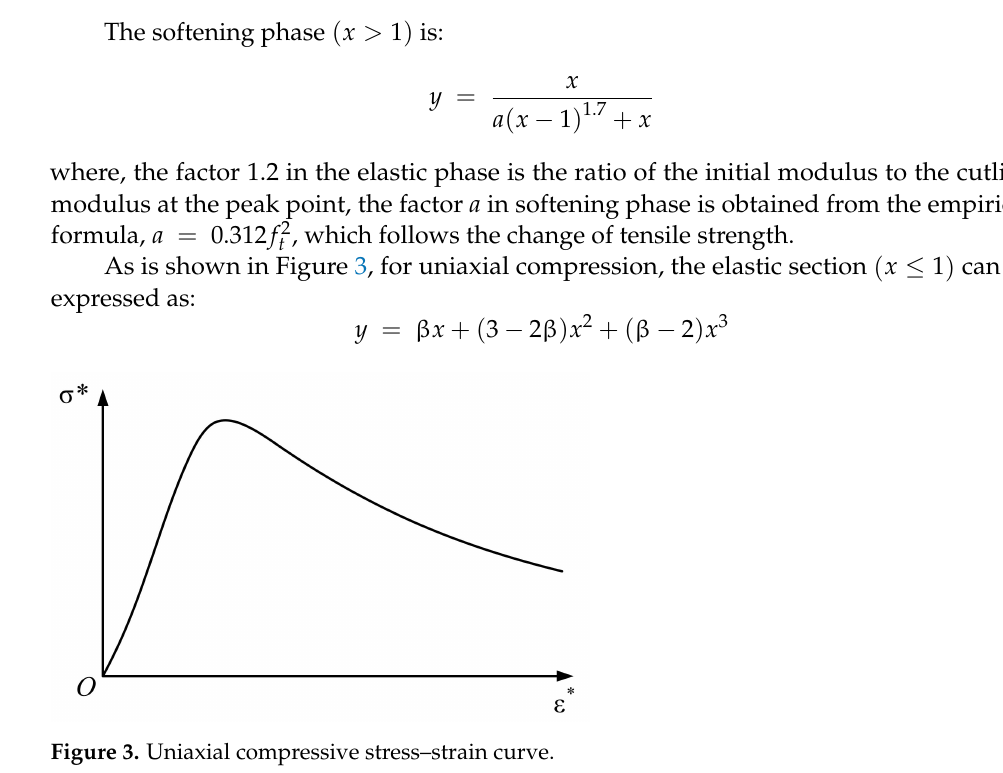
Figure 2. Uniaxial tensile stress–strain curve.